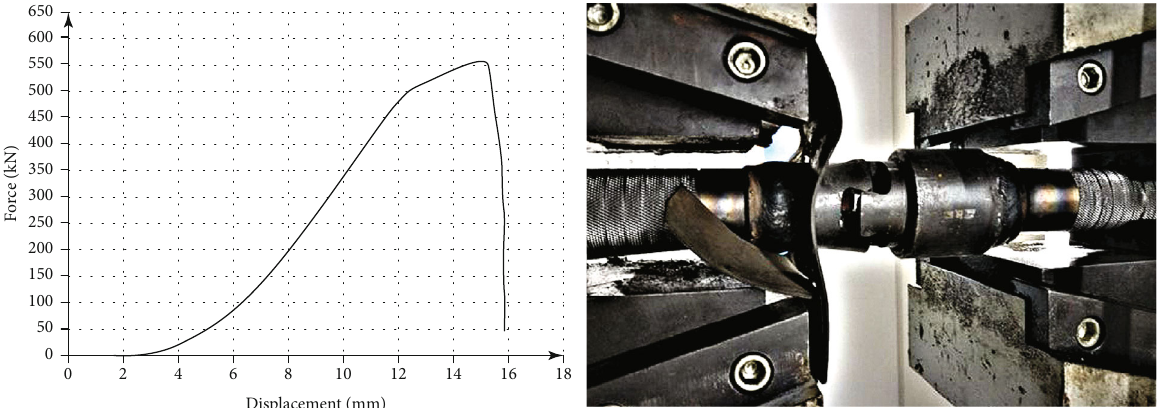
Figure 8: Tensile performance test of the bionic drill pipe.